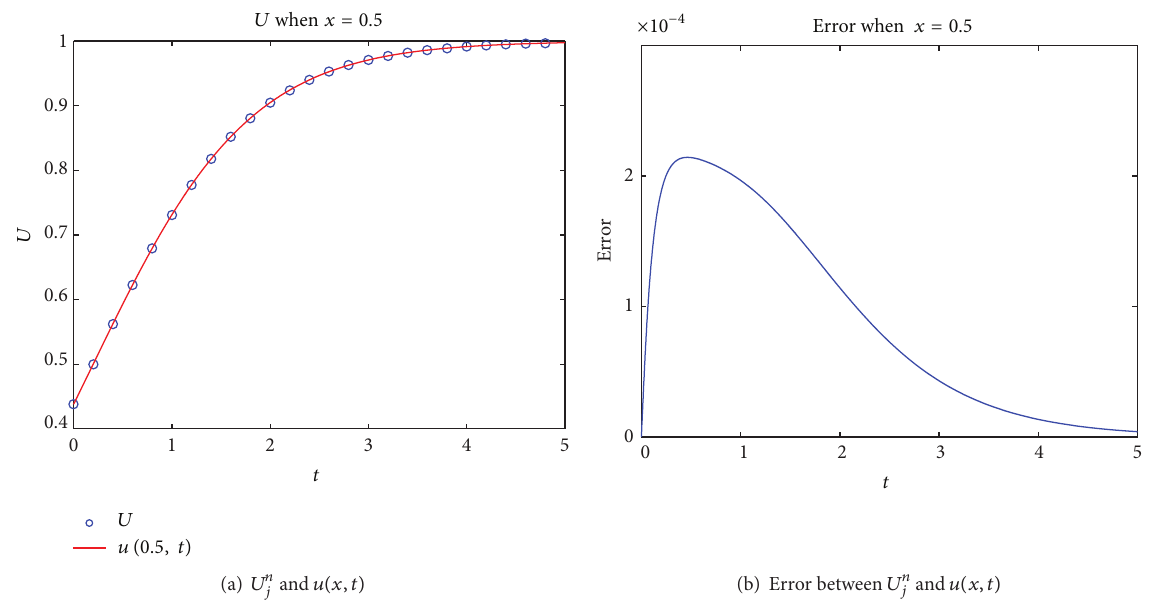
Figure 4: 𝑈 and 𝑢(𝑥,𝑡) at a fixed value 𝑥 = 𝑥 = 0.5 for NSFD scheme